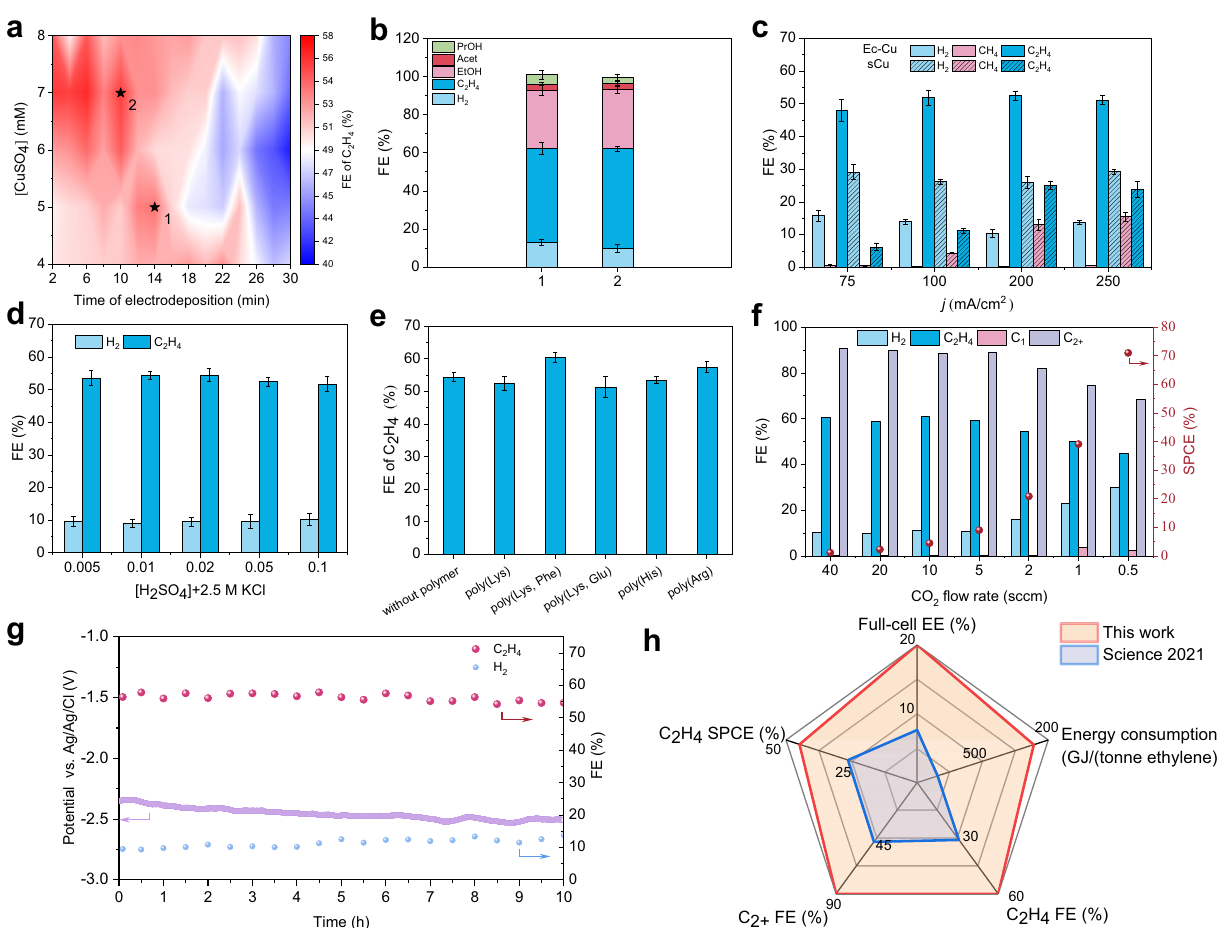
e Performance of different poly(amino acid)s modi fi ed EC – Cu-2. f SPC of acidic CO 2 R. g Cell voltage, FE C2H4 and FE H2 of acidic CO 2 R in a fl ow cell. h Full-cell EE, energy consumption, C 2 H 4 FE, C 2+ FE and C 2 H 4 SPCE compared to the best prior results for acidic CO 2 R. All the error bars correspond to the standard deviation of three independent